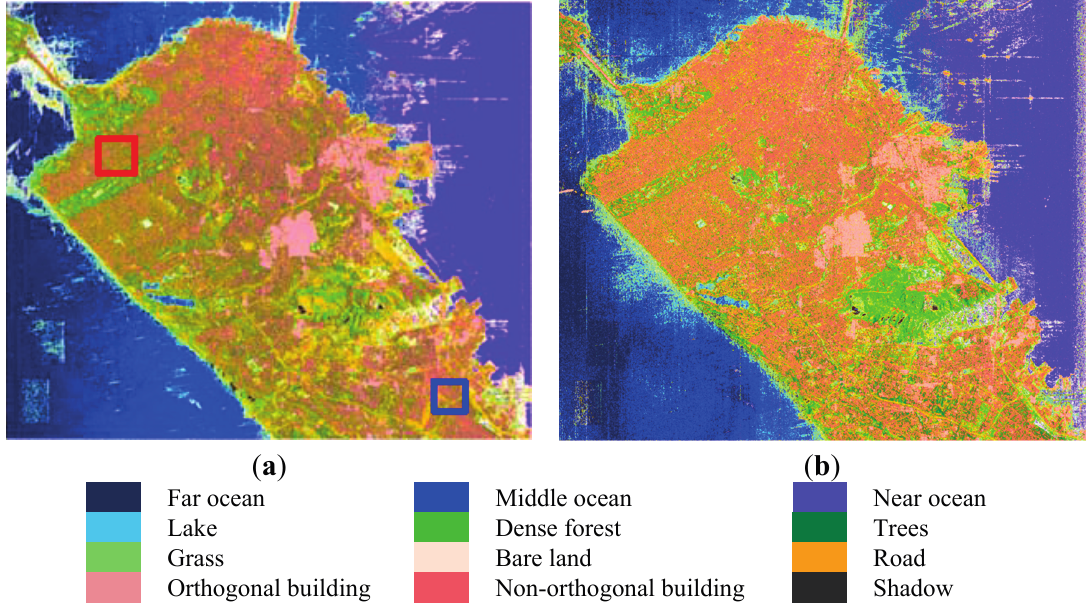
Figure 5. Classification results of POL-only and TF-only on L-band data. ( a ) POL-only; ( b )